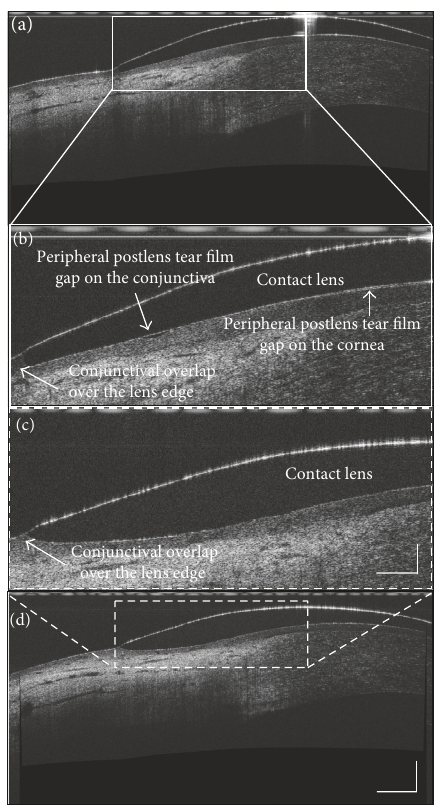
Figure 1: Edge conjunctival coverage and PoLTF underneath the peripheral lens. Conjunctival response to soft contact lens was characterized as an overlap of conjunctival tissue at the edge of the lens. The PoLTFs on the cornea and on the conjunctiva were clearly visualized as gaps between the lens and the ocular surfaces in (b). One was located at the peripheral cornea, and the other was located at the limbal transition to the conjunctiva. (b) and (c) were the magnified images of (a) and (d). (a) and (b) are balafilcon A lenses. (c) and (d) are galyfilcon A lenses. The bars denote 100 µ m for two of the images (a) and (d) and 250 µ m for the other two images (b) and (c).